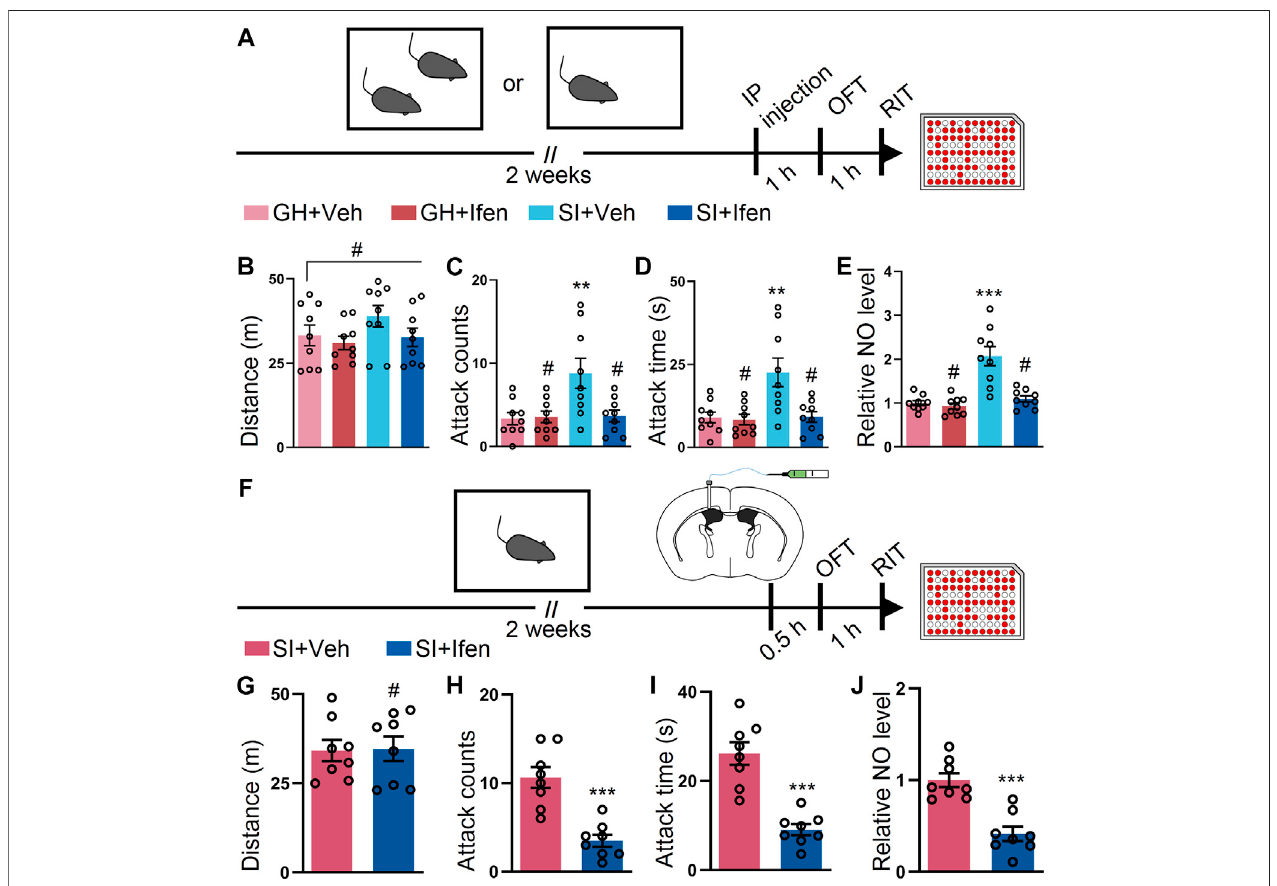
FIGURE 1 | Inhibition of the GluN2B-containing NMDA receptor by ifenprodil mitigates the SI-induced exacerbated attack behavior. (A) Schematic of the time course oftheexperiments. Themice wereeithergroup-housed(GH)orsingle-housed(socialisolation, SI)for2 weeks.After2 weeks,themicewereintraperitoneally(IP) injected with the vehicle (Veh) or ifenprodil (Ifen) 1 h before the open fi eld test (OFT), and then subjected to the resident – intruder test (RIT) 1 h later. (B) Total distance of micetreatedasshownin (A) duringtheOFT(F 3,32 (cid:1) 1.536, p (cid:1) 0.224). (C) Attackcountsofmicetreatedasshownin (A) duringtheRIT(F 3,32 (cid:1) 5.877, p (cid:1) 0.0026). (D) Totalattacktimeofmicetreatedasshownin (A) duringtheRIT(F 3,32 (cid:1) 7.282, p (cid:1) 0.007). (E) TherelativeNOlevelofthecortexfrommicetreatedasshownin (A) (F 3, (cid:1) 18.95, p < 0.001). (F) Schematic illustrating the experimental procedure. The mice were implanted with a guide cannula and singly housed for 2 weeks. Afterward, 32 ifenprodil was intracerebroventricularly (ICV) injected, and behavioral tests were performed. (G) Total distance of mice treated as shown in (F) during the OFT (t 14